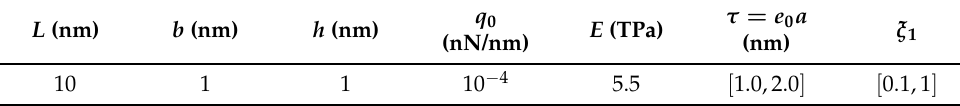
Table 1. Geometry, loading, and material parameters of the nanobeam.